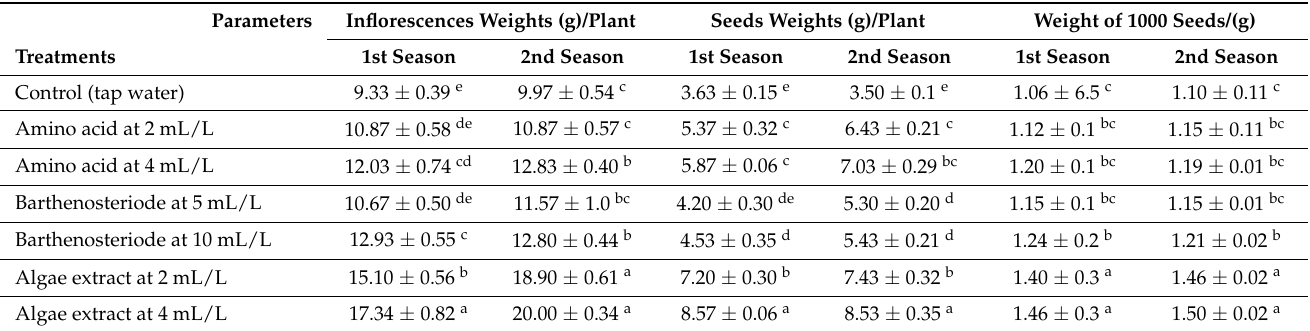
Table 4. Effect of bio-stimulant treatments on chia inflorescences weights, seed weights and weights